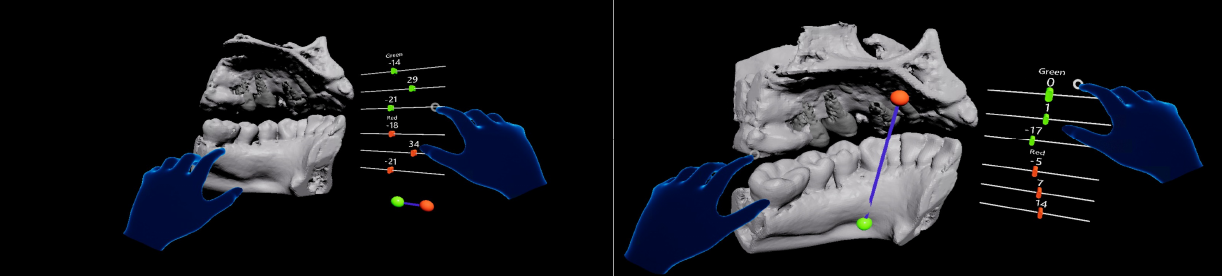
Figure 7. The application of the MR in dental education. This view is displayed for users wearing the Microsoft HoloLens 2.